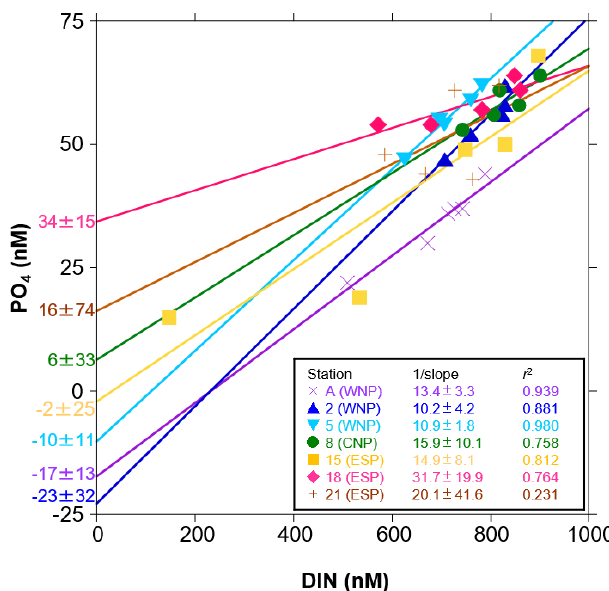
Figure 4. Scatter plots of the control-corrected mean concentrations of PO 4 against DIN in the incubation experiments at seven stations. Linear regression lines with their parameters (1 / slope, PO 4 inter- cept, and r 2 ) at seven stations were denoted by the different colours. Errors of 1 / slope and PO 4 intercept represent 95% confidence in-